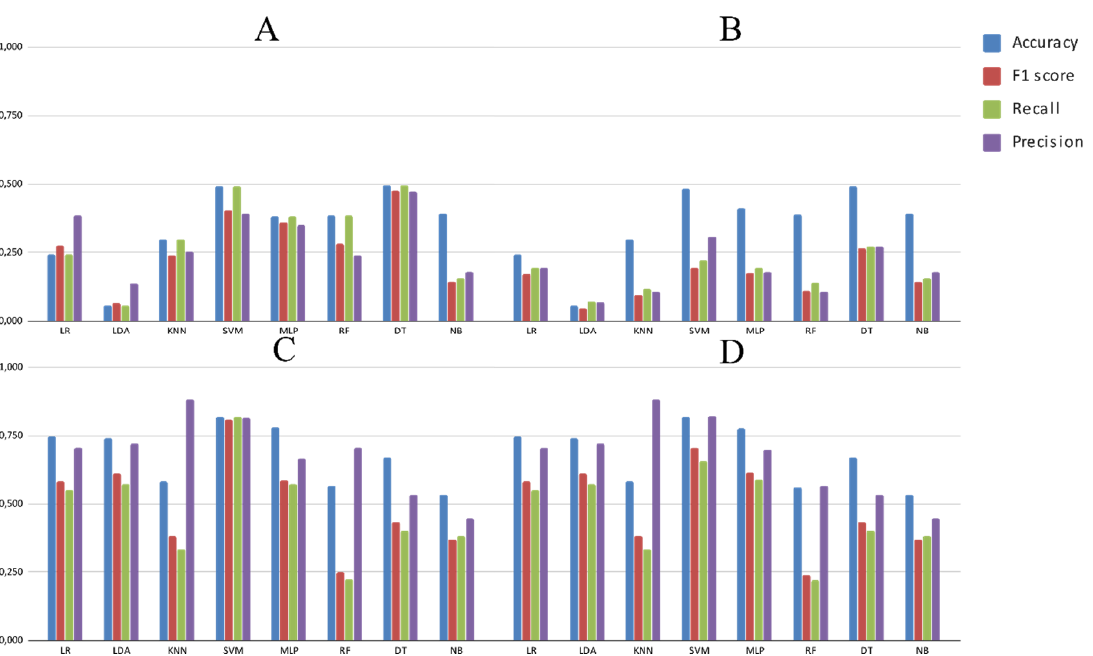
and ( D ) Exp4. ( C ) Exp3,